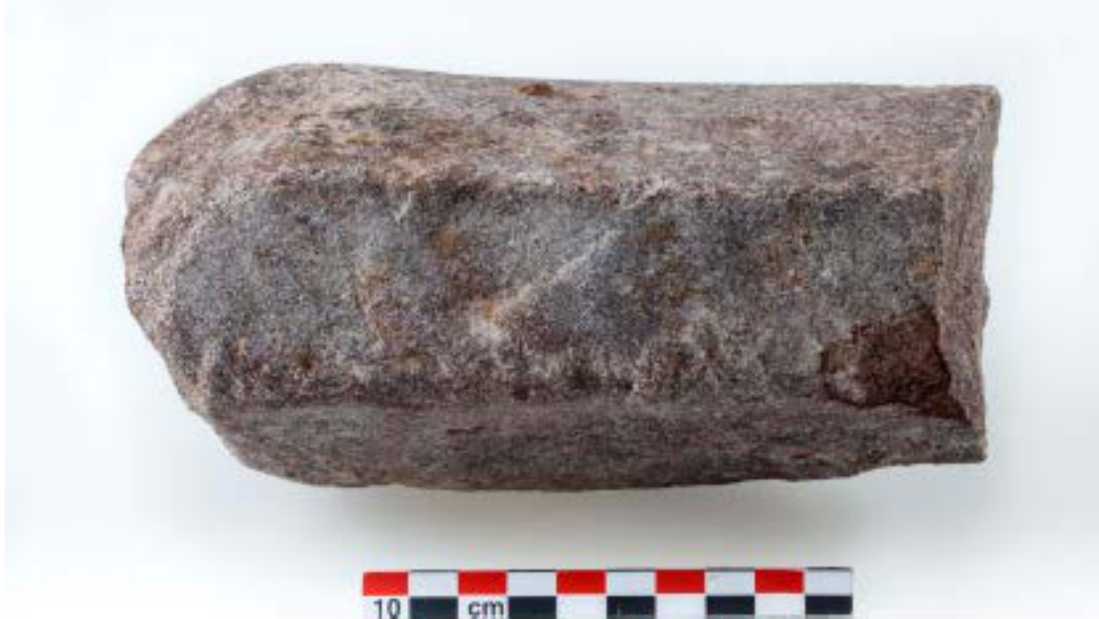
Figure 5. Back of a quern upper stone RLT 2-1104 with a prehensile “bar” serving to grip the tool (photo: Fr. Schneikert, AA).